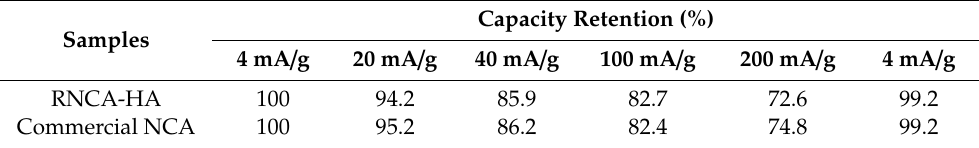
Table 3. Capacity retention of RNCA-HA and commercial NCA at various